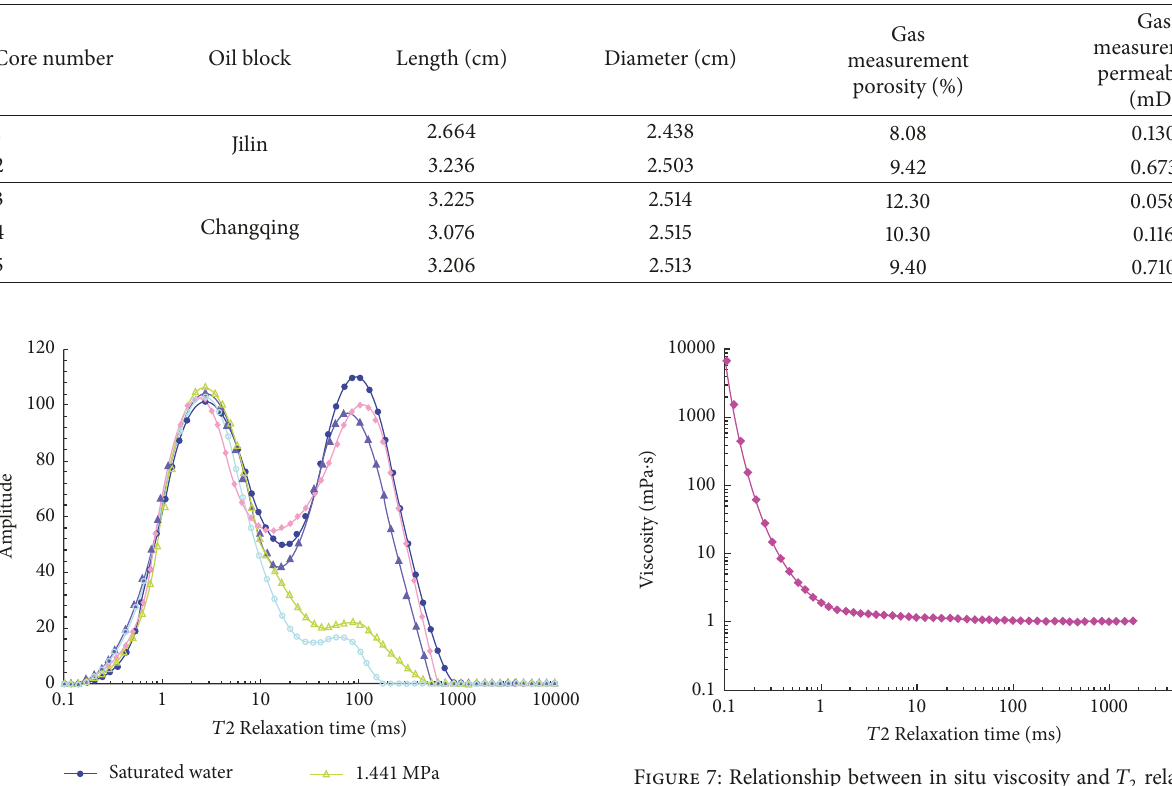
Table 1: Petrophysical parameters of 5 tight rock cores.